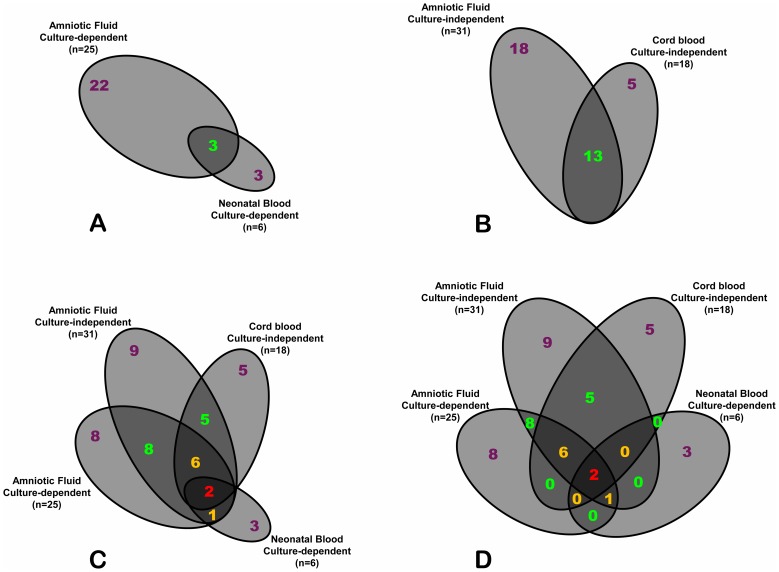
Euler-Venn diagrams showing the number of species shared among compartments of each case (co-occurrences).Compartments of each case were analyzed by either the culture-dependent (A) or culture-independent methods (B). The size of each space (ellipse) is proportional to the number of species in each compartment. 4-way intersecting diagrams of the 4 compartments showing either non-null spaces that are proportional to the number of species (Euler-like diagram) (C) or the complete non-scaled design which includes spaces with no overlapping species (Venn diagram) (D).